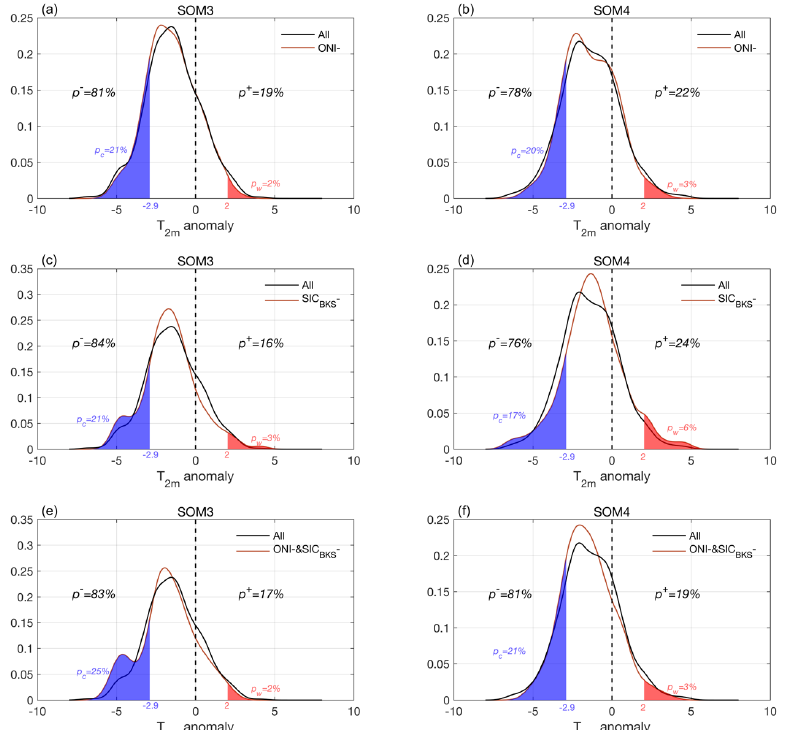
Figure 11. The probability density distributions of the two cooling SOM modes for negative ONI and SIC BKS : ( a , c , e ) SOM3; ( b , d , f ) SOM4. Black line is the probability density distribution based on all days of the corresponding SOM group, as in the distribution in Figure 10. The red line is the distribution for negative ONI ( a , b ), negative SIC BKS ( c , d ), and co-occurrences of negative ONI and negative SIC BKS ( e , f ). The percentages and shaded areas have the same meanings as in Figure 10.